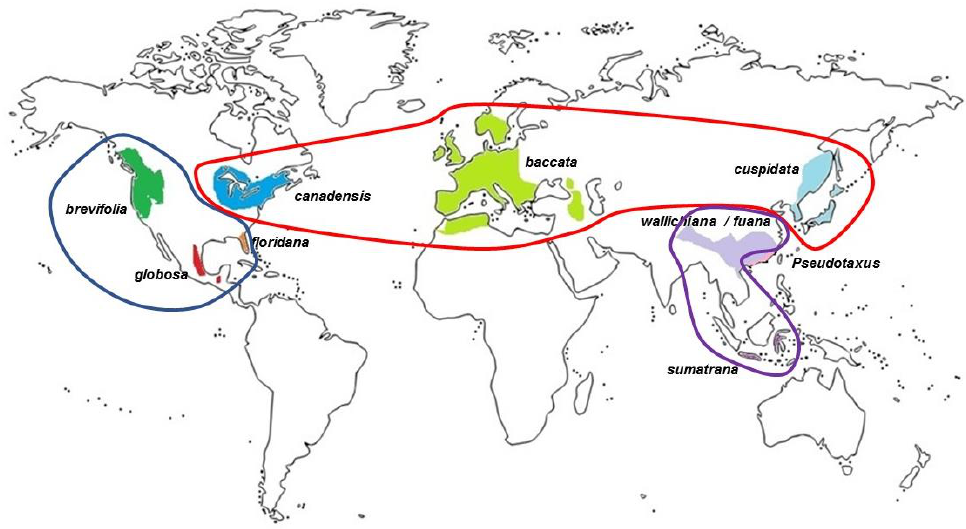
Figure 1. Distribution of Taxus species and its sister genus Pseudotaxus . Adapted and modified from Li et al. [10]. Groupings of ITS sequences in relation to the biogeography of Taxus are also shown. Blue, red and purple ellipses represent phylogenetic groupings from the TCS network analysis (Figure 4).